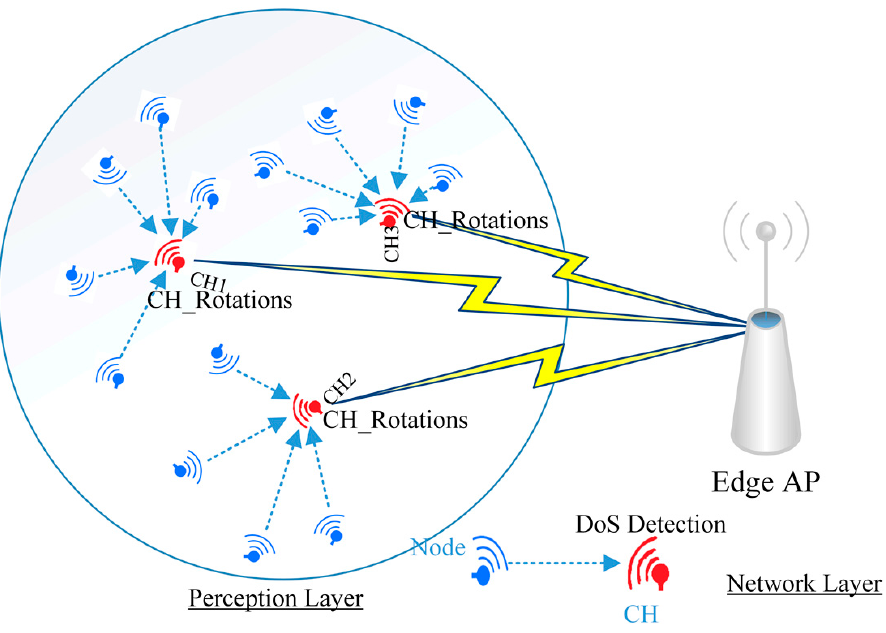
Figure 2. The structure of the general proposal model.